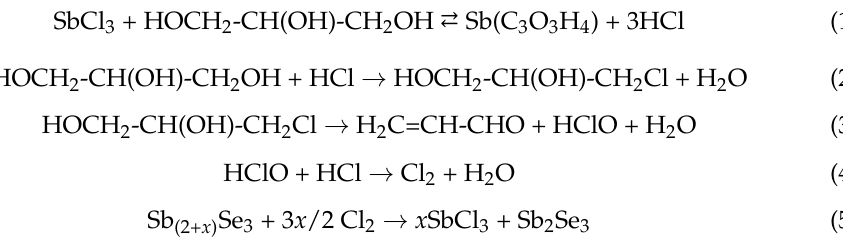
Table 1. The atomic percentages of antimony and selenium according to the EDX data, the arith- metic average of the absolute values of the surface height deviations ( R a ) according to the AFM data, optical direct band gap values ( E g ), the average crystallite size (D), and lattice parameters of Sb 2 Se 3 films depending on the molarity (M) of SbCl 3 in glycerol. Each parameter was determined by averaging the values obtained three measurements for each sample. The error represents the standard deviation.